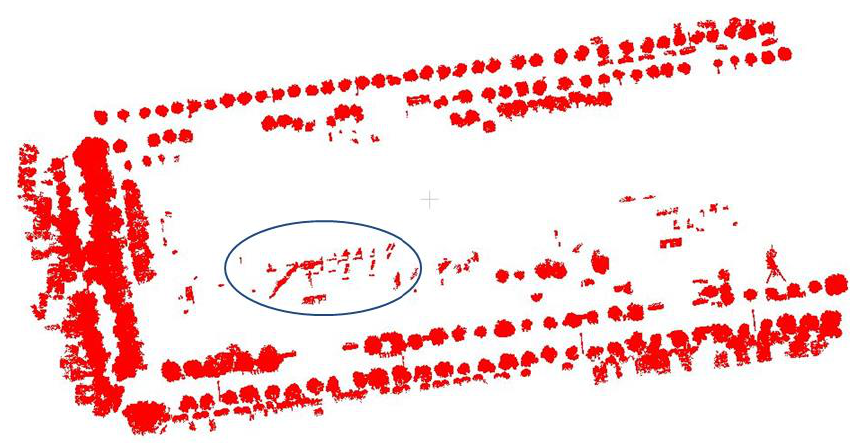
Figure 7. Filtering and pre-processing results (building residues in blue circles). The non-tree points left by the filter pre-processing include some building points and bicycle points that are closely connected to tree trunks, etc. The building points are not excluded in the area difference projection filtering B 1 because the top surface has a projected width. The bicycle points close to the tree are in the same cluster as the tree trunk and are retained in the scale calculation filtering B 2 because they meet the threshold conditions. The results obtained after the vertical linear extraction ( Linearity ) process and the trunk point extraction process based on the GDRG algorithm are shown in Figure 8. The building points left by the filtering pre-processing are further simplified by the vertical linear extraction process, keeping the more clearly expressed components such as doors, windows and columns. The bicycles near the trunk of the tree are extracted by vertical linear extraction, and the connection with the trunk points is removed, so that only a small number of bicycle points are retained.